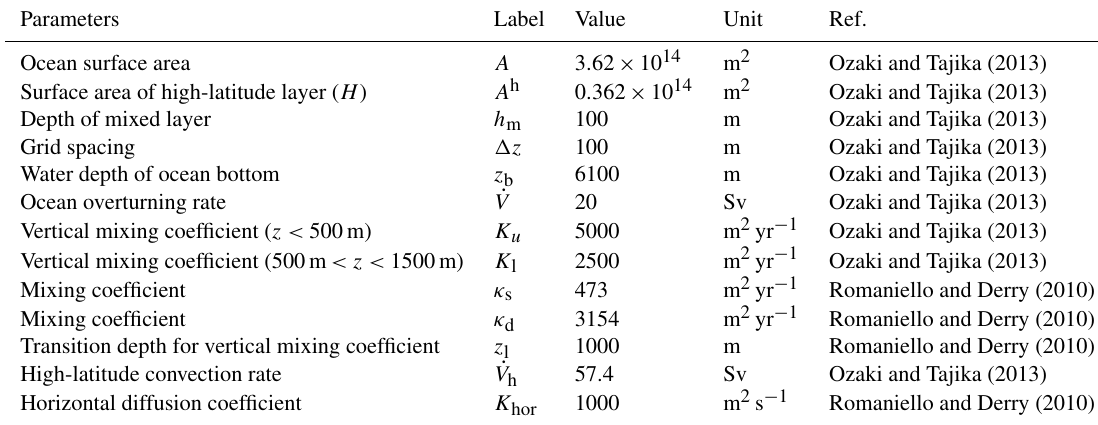
Table 3. Physical setup of the ocean circulation model.